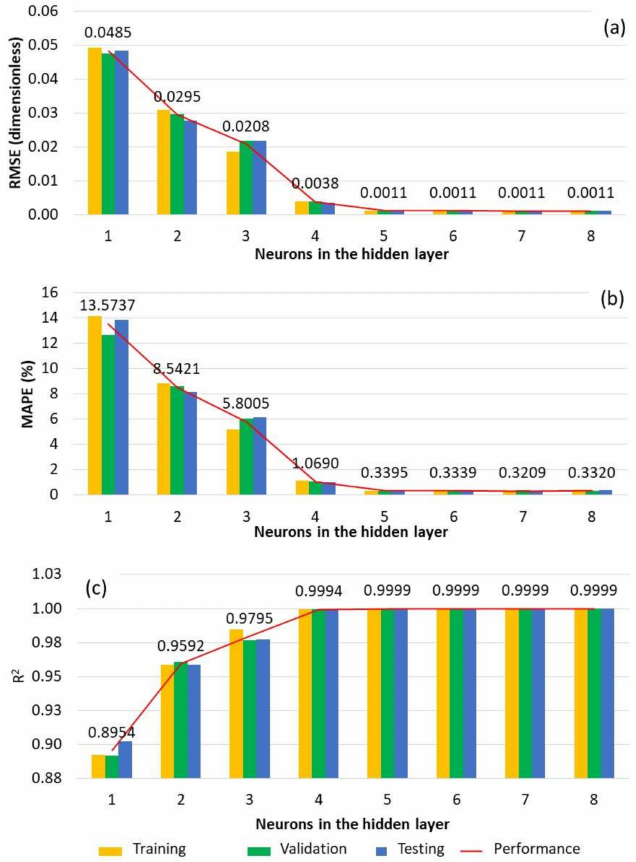
Figure 5. Statistical analysis for the diverse ANN architectures evaluated: ( a ) RMSE performance, ( b ) MAPE performance, ( c ) R 2